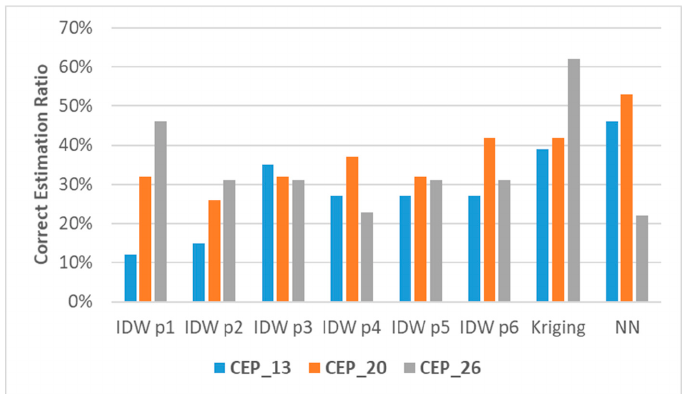
Figure 8. Correct estimation ratio for selected interpolation techniques for lowest RMSE tests.